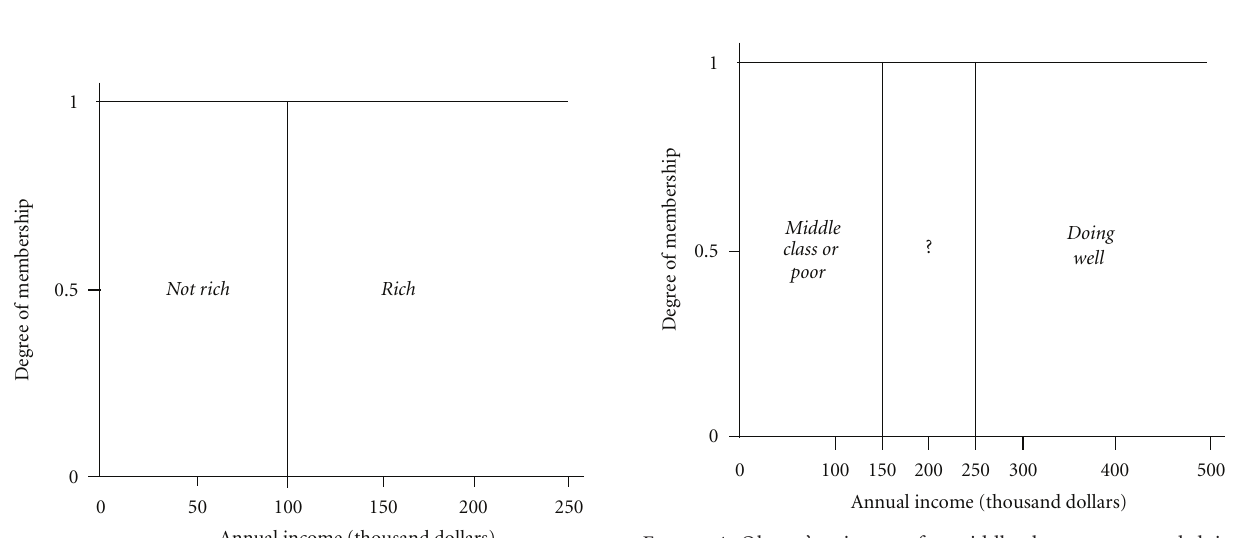
Figure 1: Warren’s crisp sets for rich and not rich with his dividing line of $50,000.